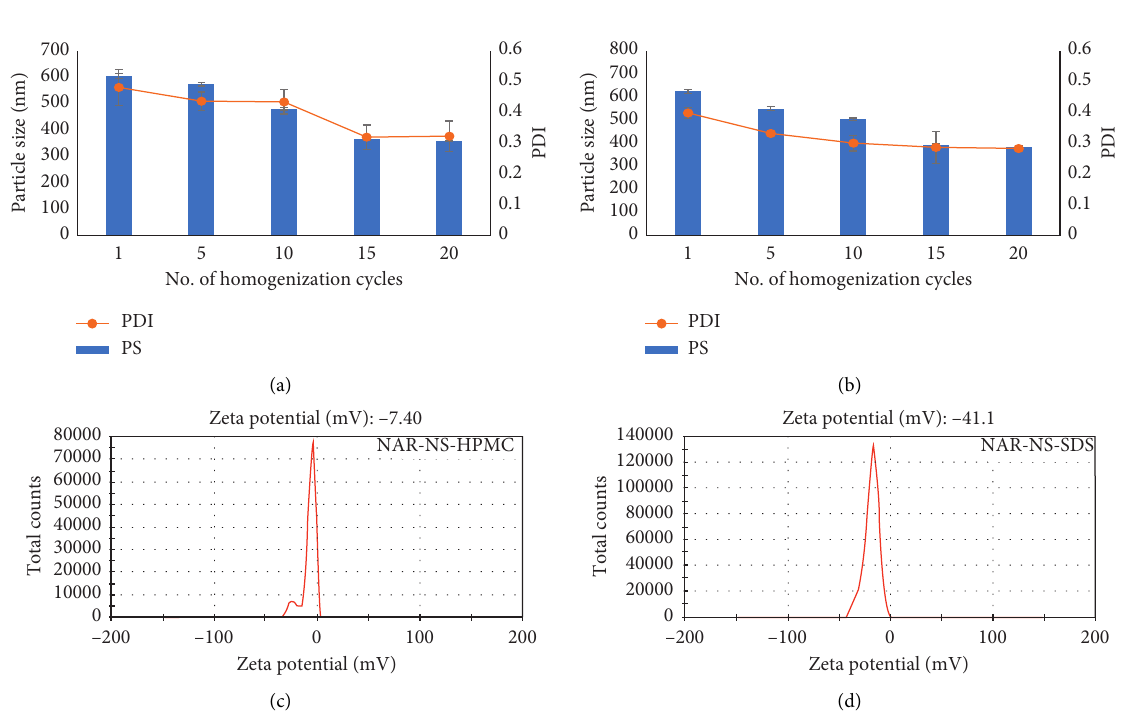
Figure 1: Mean particle size and polydispersity index (PDI) as a function of cycle numbers. 1, 5, 10, 15, and 20 homogenization cycles and pressure 1500bar ( n � 3) for the HPMC-stabilized NAR nanosuspension (a) and the SDS-stabilized NAR nanosuspension (b). (c, d) Zeta potential of HPMC- and SDS-stabilized NAR